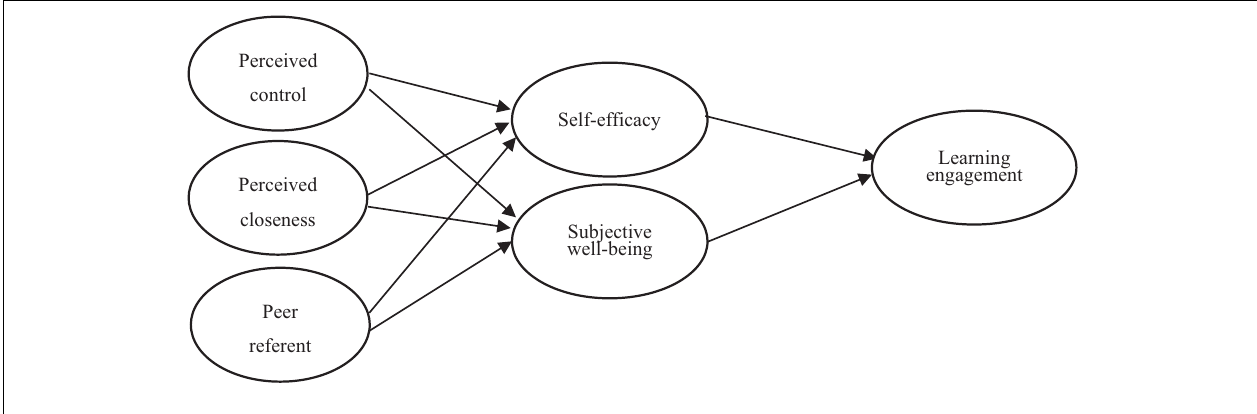
FIGURE 1 | Research